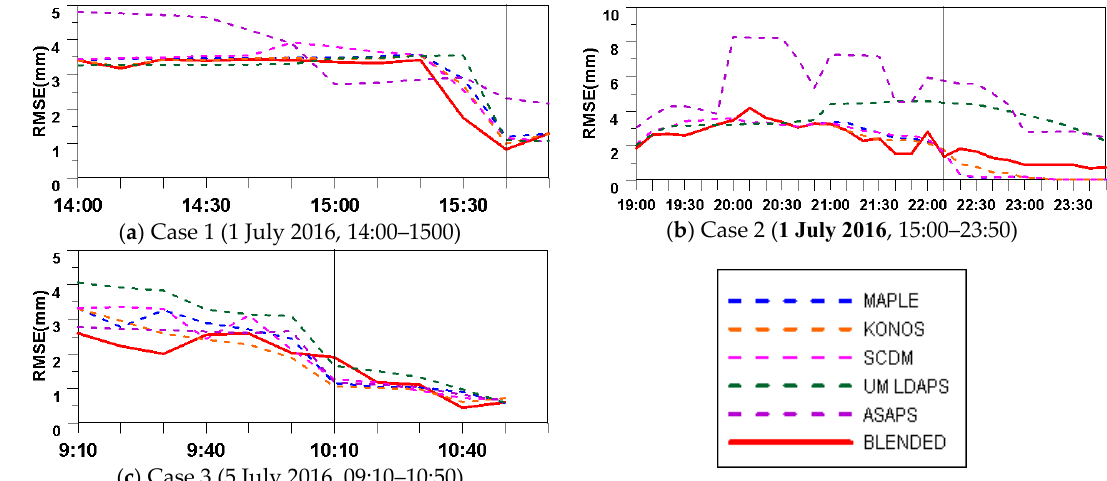
Figure 7 . Accuracy evaluations (by root mean square error) for real-time QPF produced by the five tested models and the blended approach for all three cases. Grey line marks peak actual precipitation.